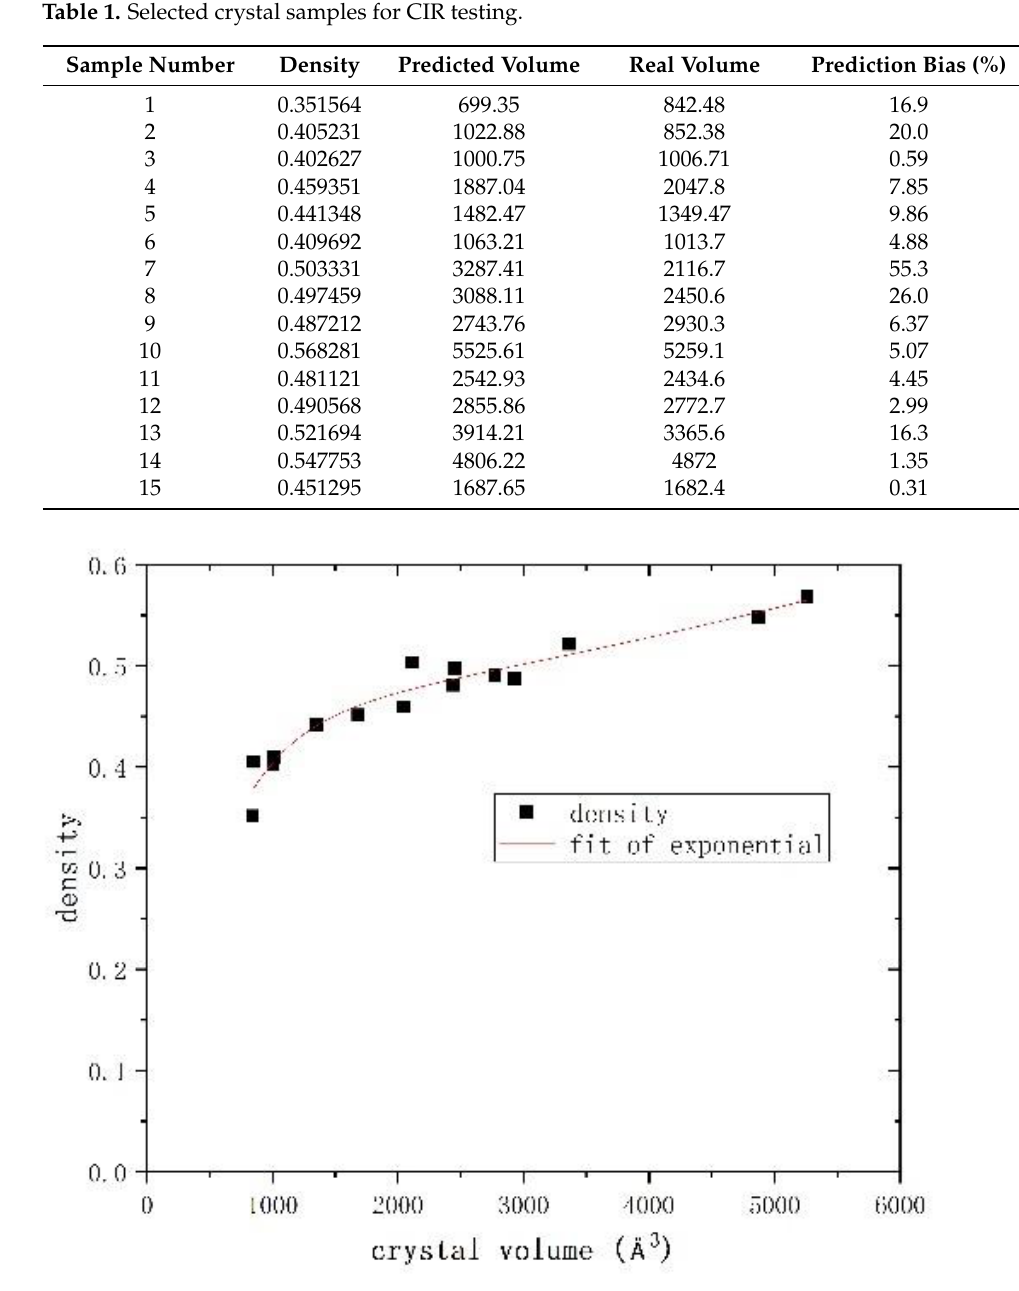
Figure 12. Volume-density plot for 15 testing crystal